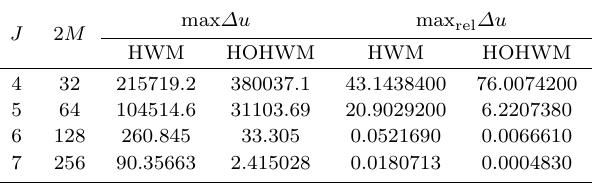
Results for the KdV equation soliton interaction: maximal deviation of the numerical solution from the exact solution max ∆u and maximal relative deviation max rel ∆u against the resolution parameter J with initial conditions (5.4) and boundary conditions (4.11) ( α = 6, c B = 10000, x 0 B = 1 / 5, c S = 10000 / 3, x 0 S = 2 / 5, x ∈ [0 , 1], t ∈ [0 , 0 . 6 × 10 − 4